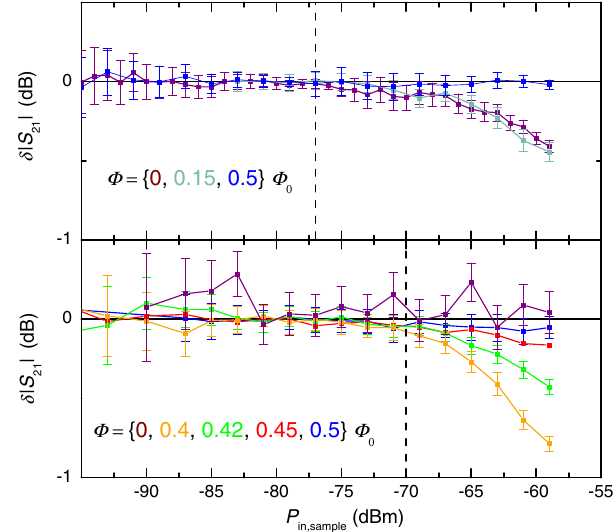
FIG. 5. Variations of the transmission through the samples (top, sample 1; bottom, sample 2), as a function of the power at the sample input, for different values of the flux through the SQUIDs, at the lowest temperature (variations are taken with respect to the ¼ − 80 dBm). The size of the error bars does not vary value at P in monotonically because the averaging time was increased when reducing the power. The dashed lines indicate the power levels that were chosen to take the data shown in Fig.